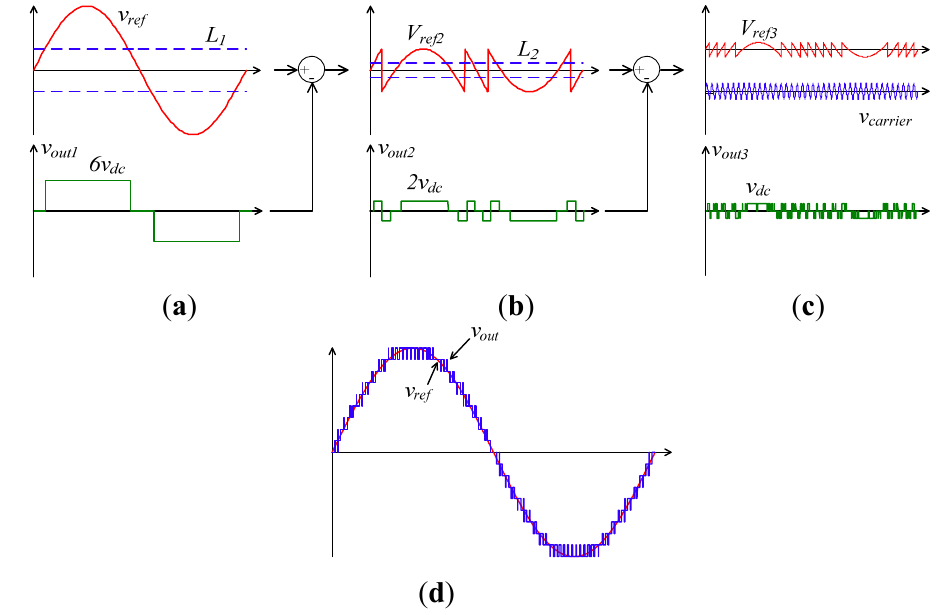
Figure 3. Multilevel modulation strategy; ( a ) cell 1 output voltage; ( b ) cell 2 output voltage; ( c ) cell 3 output voltage; ( d ) converter output